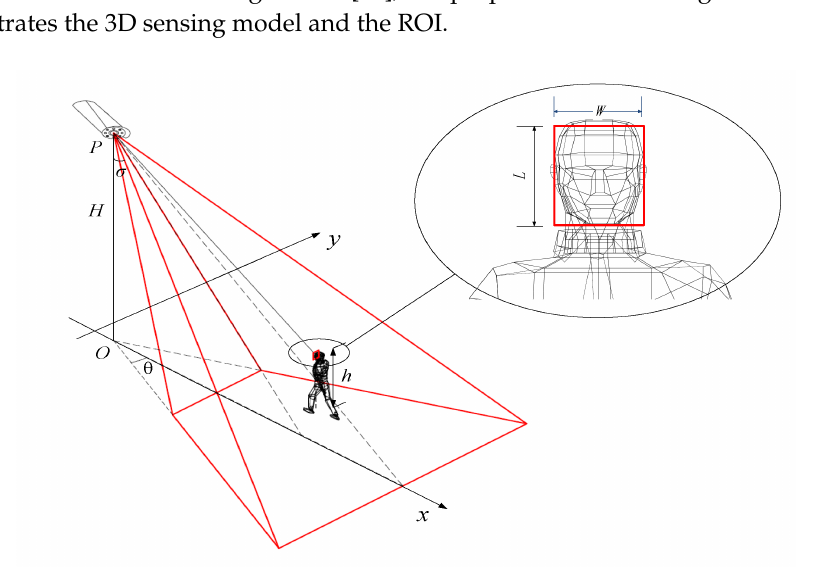
Figure 2. Three-dimensional (3D) sensing model based on region of interest